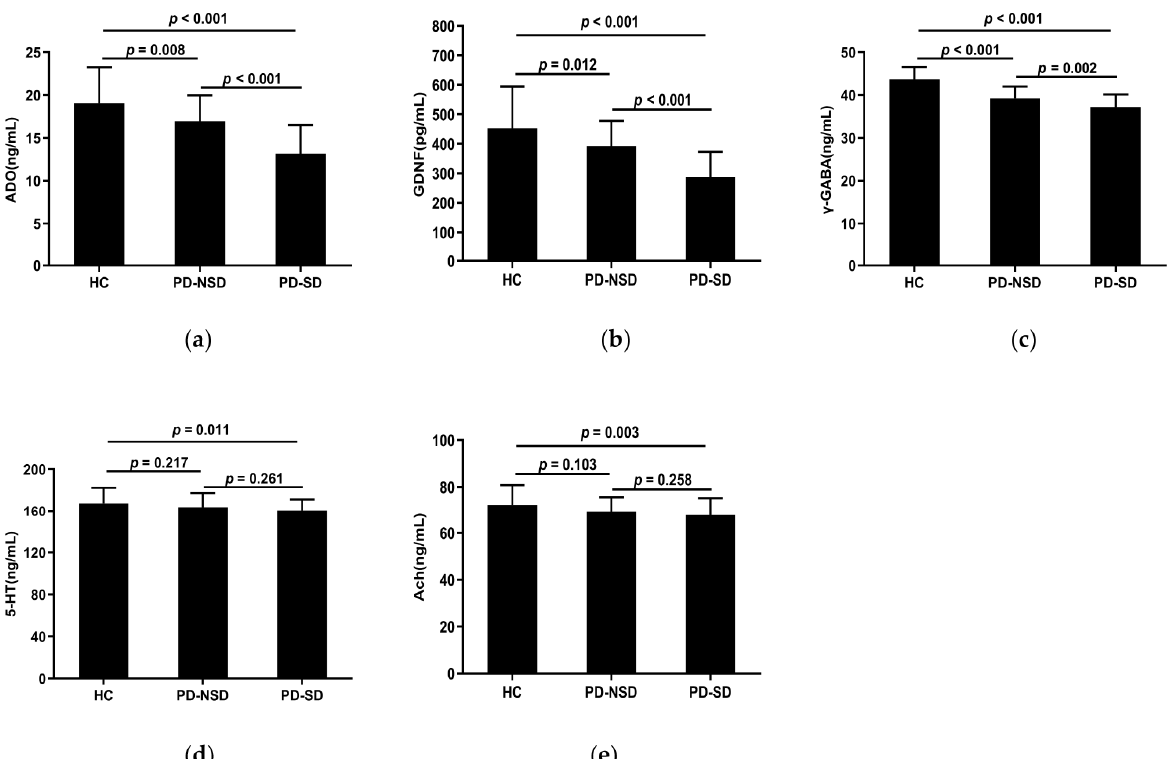
Figure 2. ( a ) The mean ADO levels of the PD-SD group (M 13.18, SD 3.31) were lower than the PD-